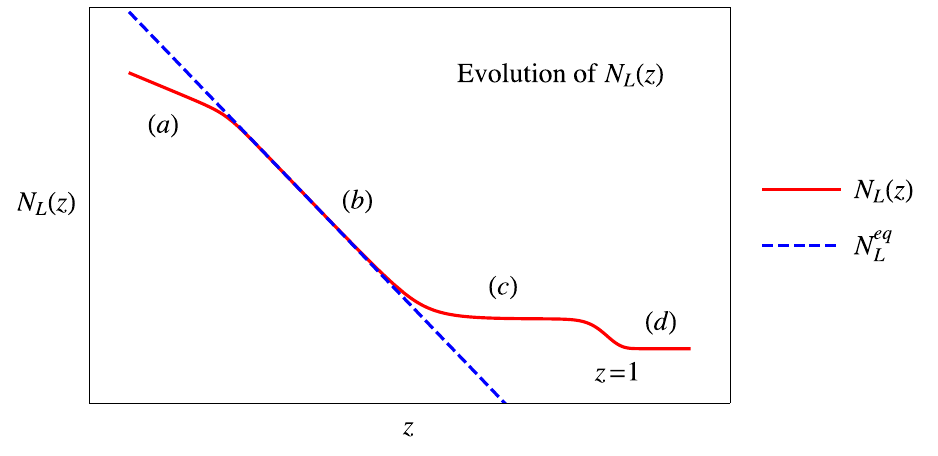
Figure 11 . Illustration of the key stages in the evolution of the lepton asymmetry N L ( z ) with temperature, given by the Boltzmann equation